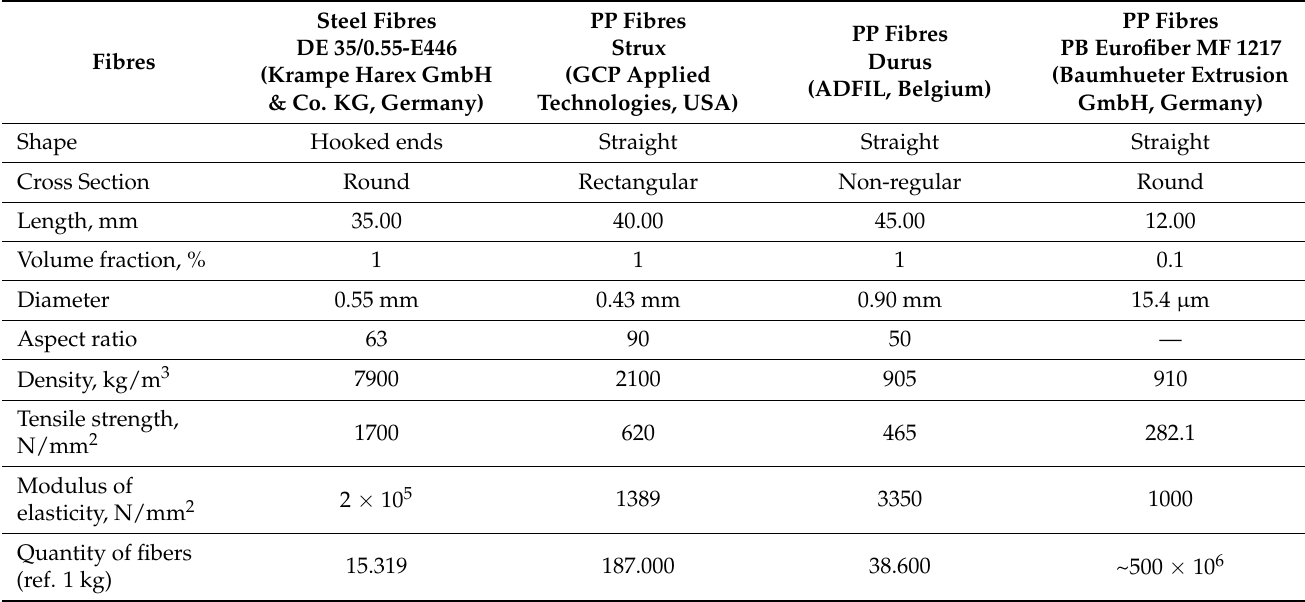
Table 1. Fiber’s specification, by supplier’s